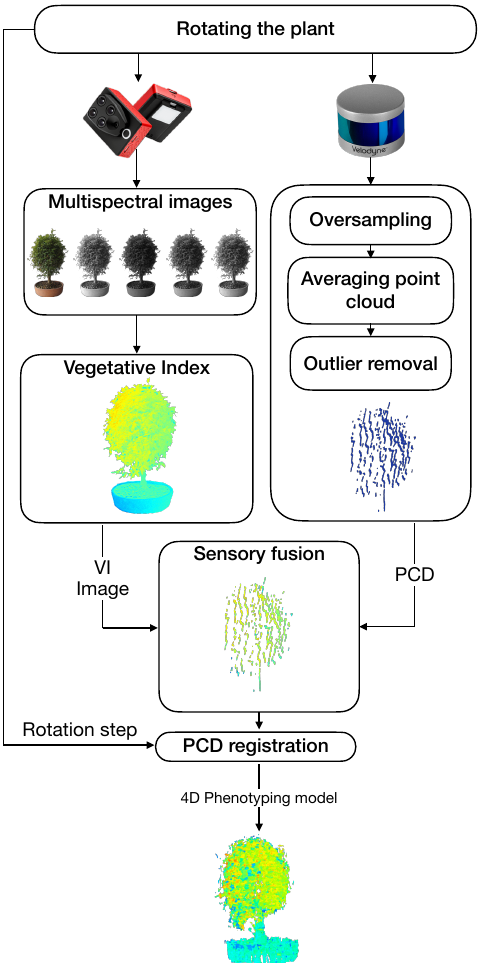
Figure 4. General architecture of the proposed 4D phenotyping system.